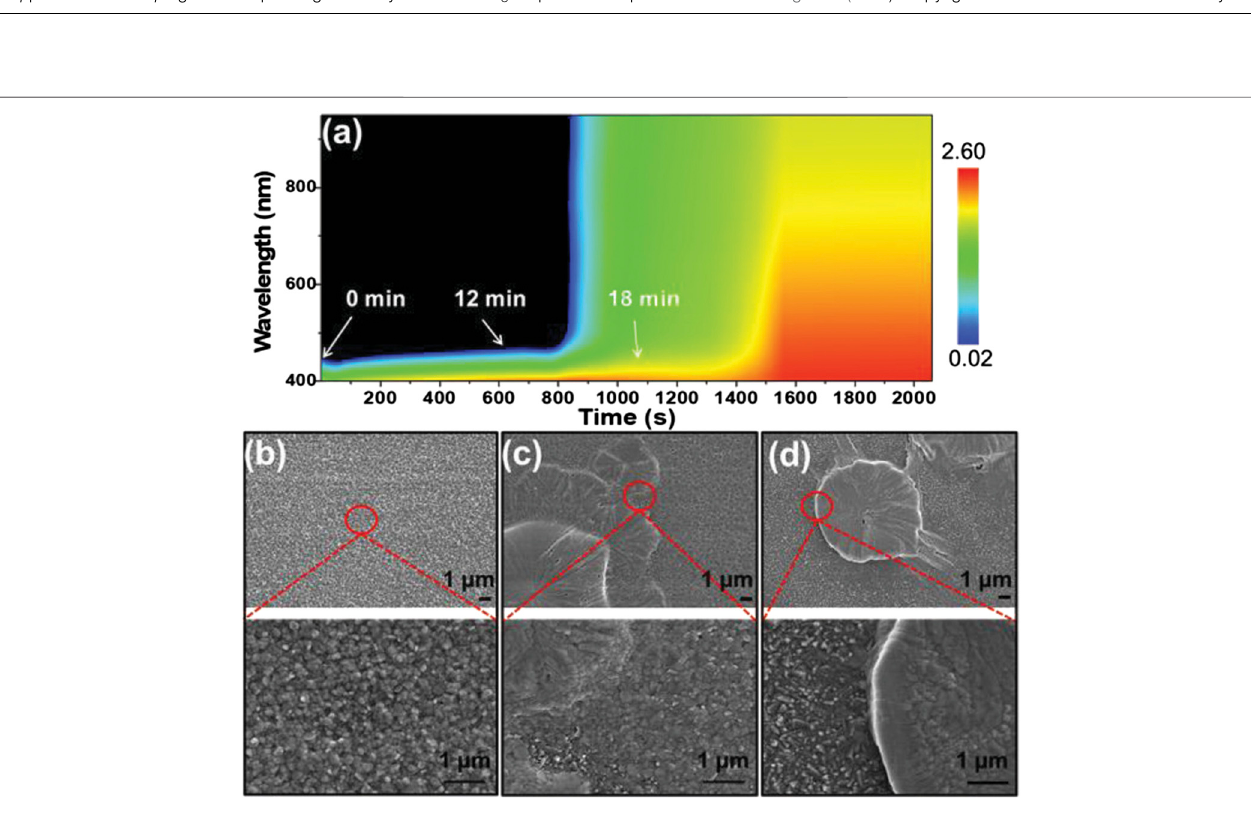
FIGURE2| Insitu GIWAXSdiagnosticsperformedduring (A) spincoatingand (B) bladecoatingofhybridperovskite fi lmsatroomtemperature and (C) intensityvs q plots of the low- q region corresponding to the crystalline MAPbI 3 . Reprinted with permission from Zhong et al. (2018). Copyright 2018 American Chemical Society.